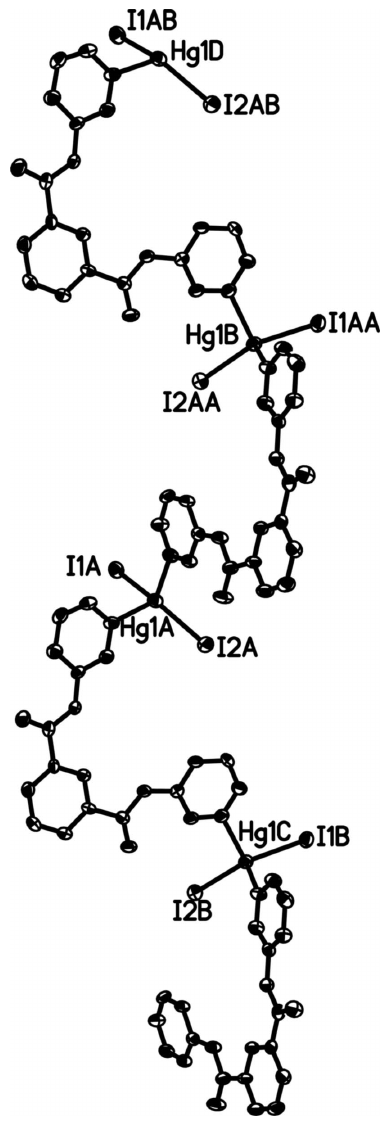
A view of the crystal packing along the c